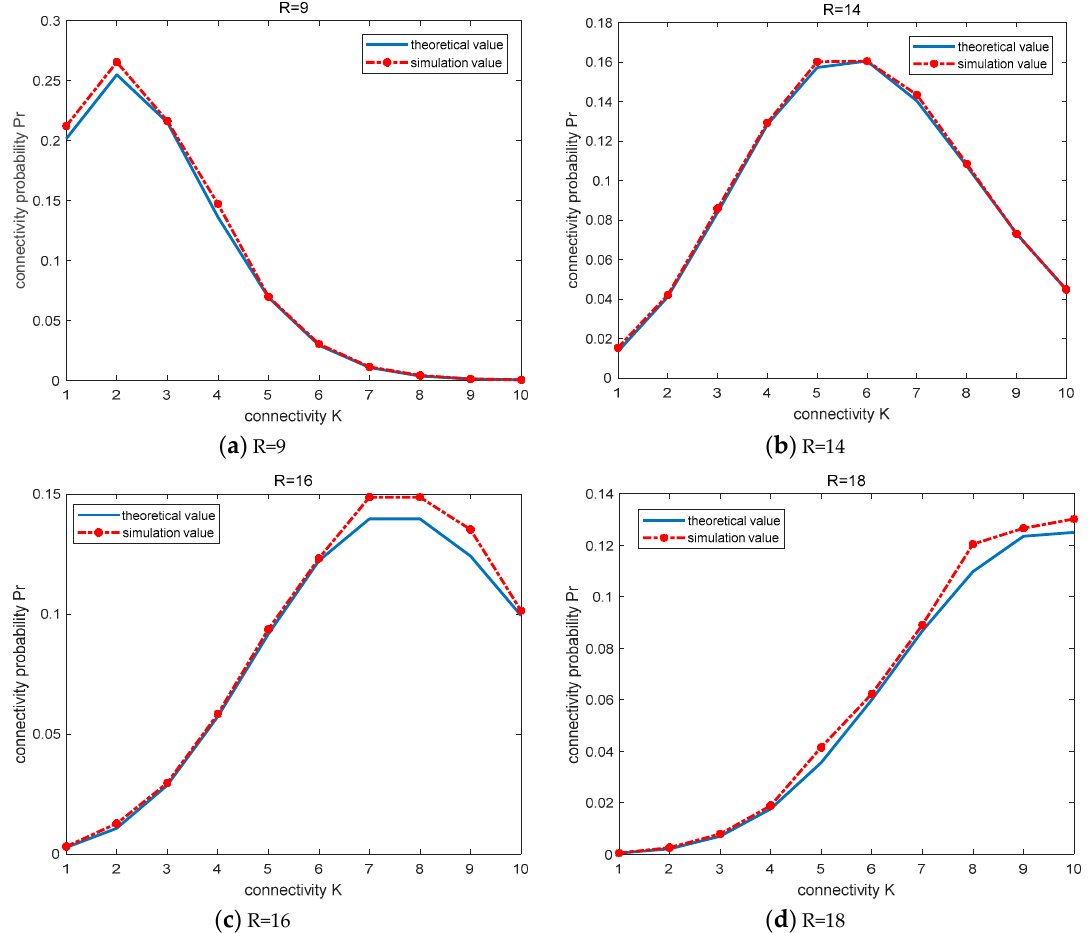
Figure 3. The relationship between the network node connectivity K and the connected probability P r .